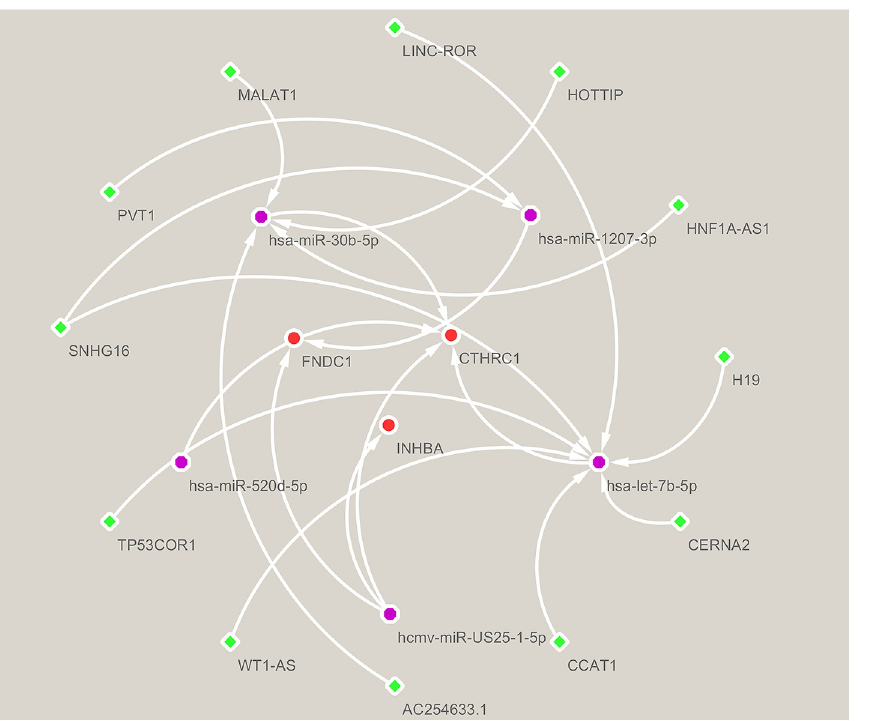
Table 1. The correlation between lncRNA, miRNA, and mRNA according to the RNAInter database.